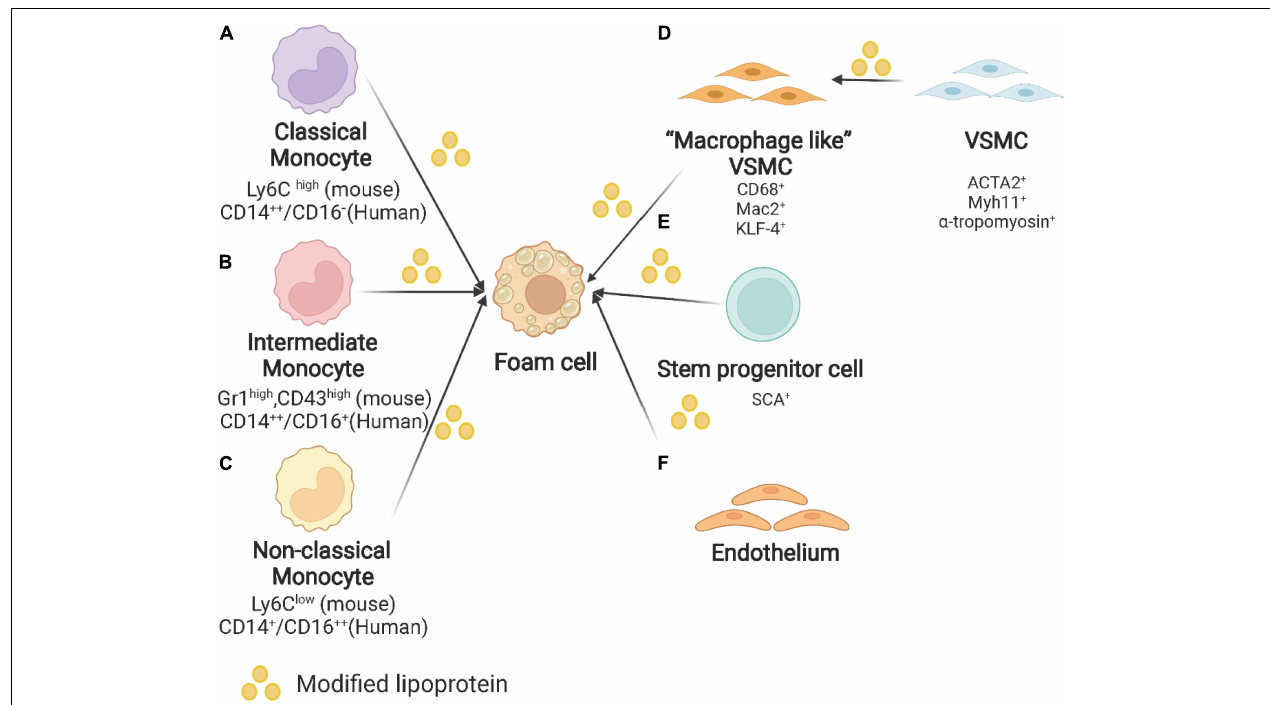
FIGURE 1 | Origin of foam cells in atherosclerotic plaques. (A) Classical monocyte: Ly6C high monocytes in mice and CD14 ++ /CD16 - in humans. (B) Intermediate monocyte: Gr1 high , CD43 high in mouse and CD14 ++ /CD16 + in human. (C) Non-classical monocyte: Ly6C low monocytes in mice and CD14 + /CD16 ++ in humans. (D) VSMC: VSMC undergoes phenotypic switching to macrophage-like VSMC and finally converts into foam cells. (E) Other origins of foam cells: stem/progenitor cells (SPCs) and endothelium. Created with